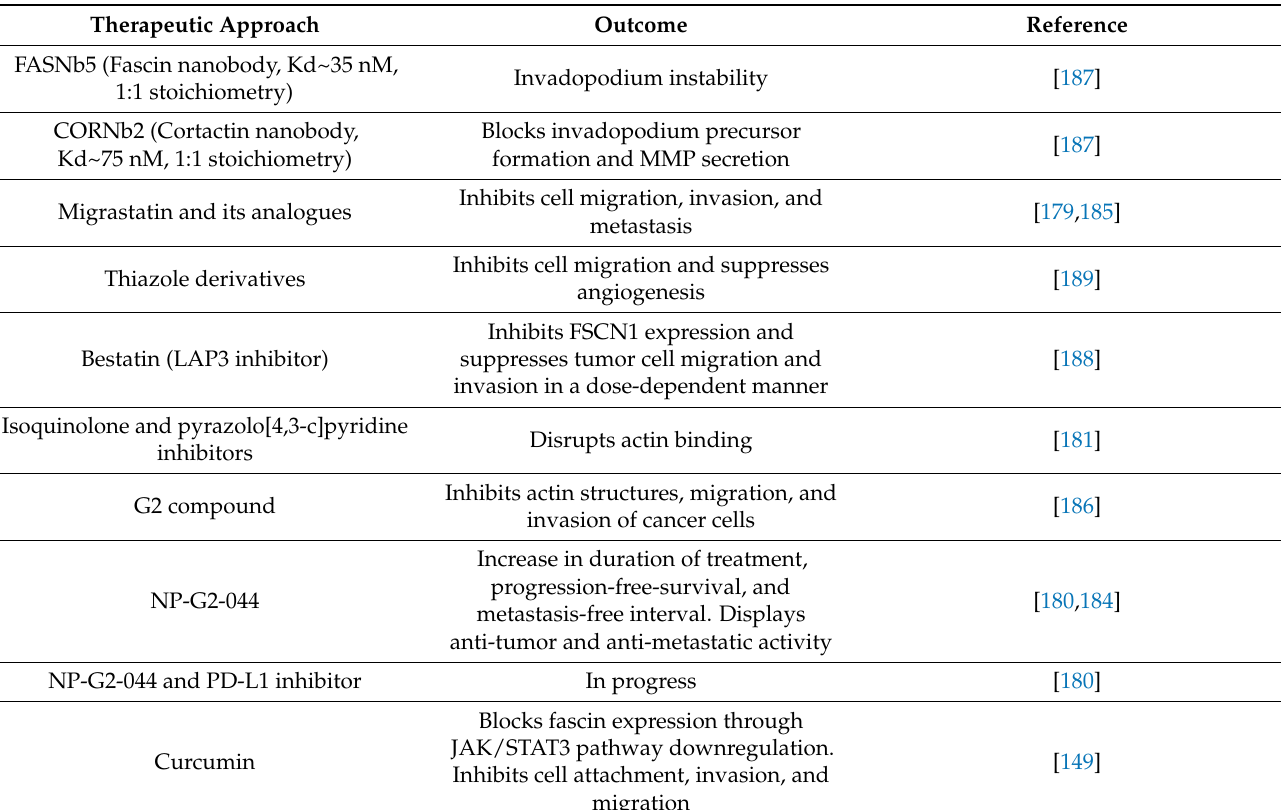
Table 2. Anti-fascin-based Therapeutic